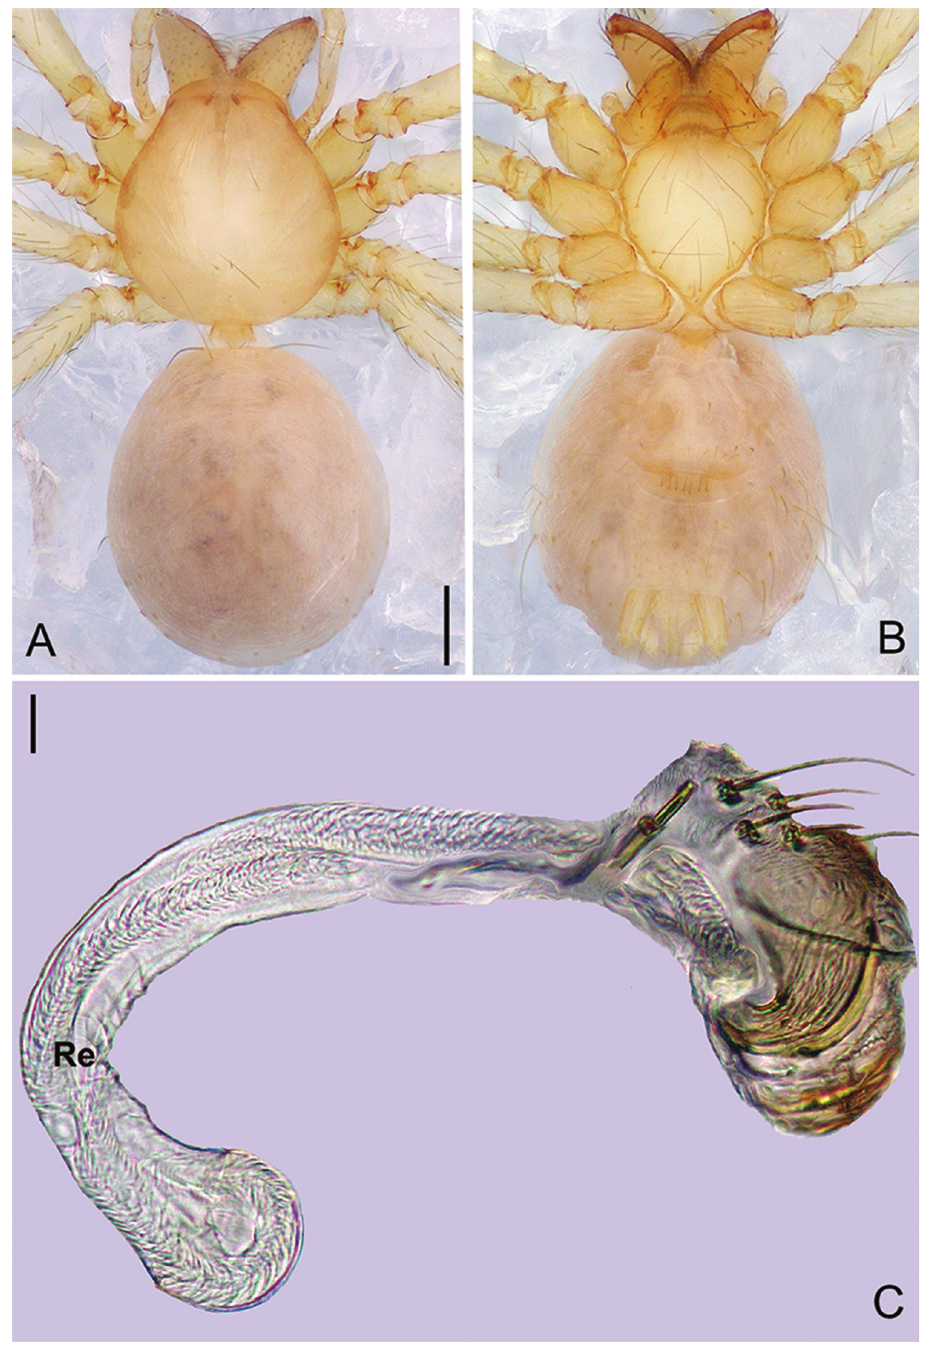
Figure 8. Pinelema huoyan Zhao & Li, sp. n., female paratype. A Habitus, dorsal view B Habitus, ventral view C Endogyne, lateral view. Scale bars: 0.2 mm ( A–B ), 0.05 mm ( C